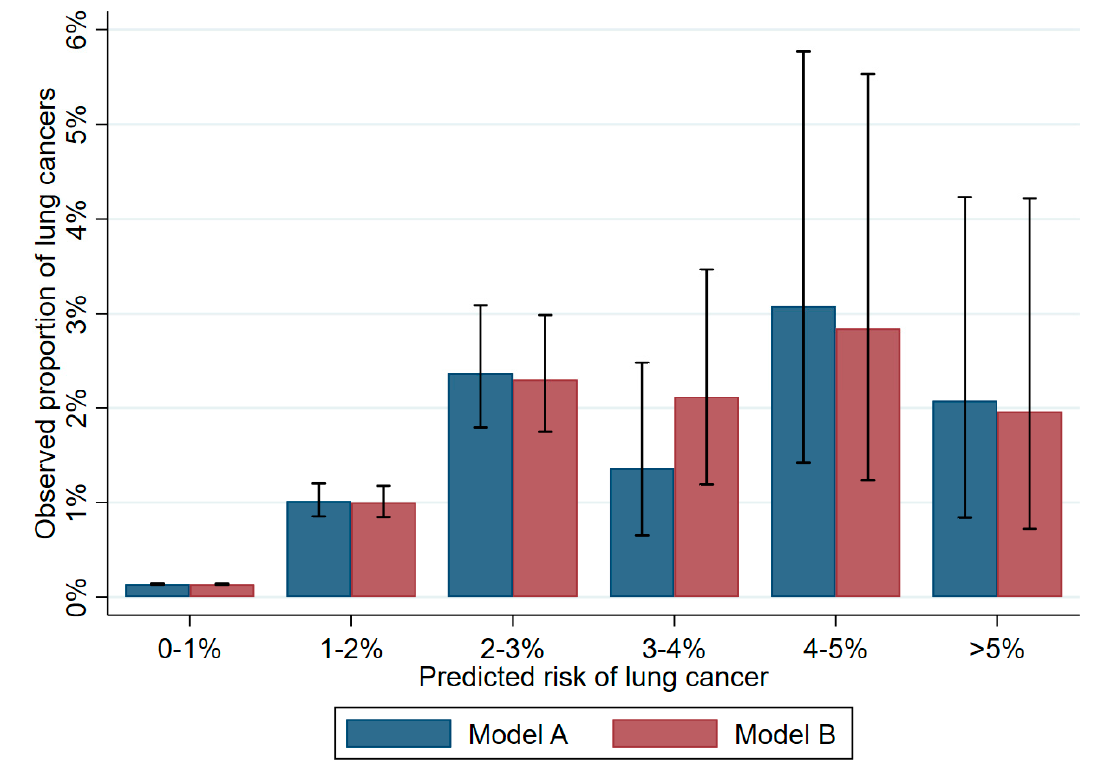
Figure 2. Predicted versus observed absolute risk of lung cancer (population 1).